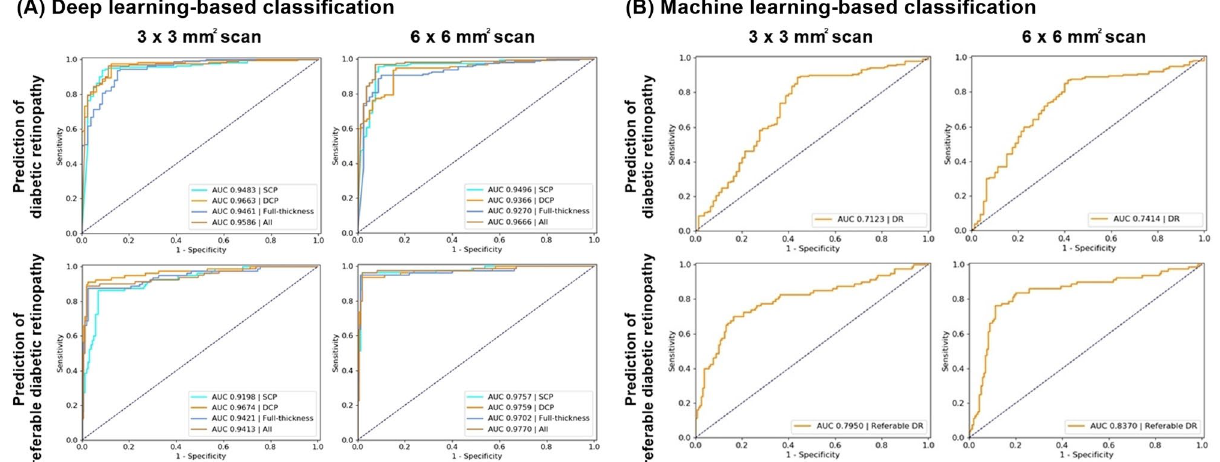
Figure 1. Receiver operating characteristic (ROC) curves illustrating classification performances for the prediction of onset and referable status of diabetic retinopathy (DR): (A) ROC curve using a deep learning- based classifier, and (B) ROC curve using a machine learning-based classifier. The dotted line represents the tradeoff resulting from random chance, and the solid curved line represents the tradeoff of the model. This figure was created using Photoscape (http:// photo scape. co. kr/ ps/ main/ index. php).